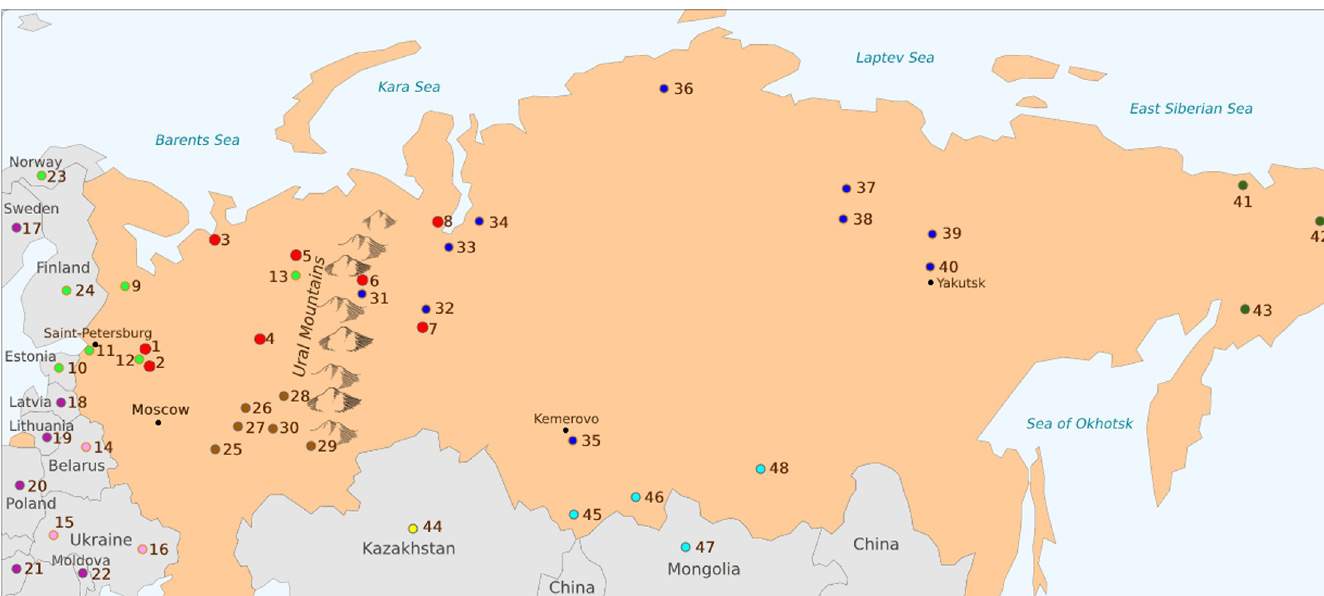
Fig 1. Geographical locations of the populations and samples studied. The numbers denote the following population samples: 1, Veps; 2, Russians from Ustyuzhna, Vologda region; 3, Russians from Mezen, Archangelsk region; 4, Priluzski Komi from Ob’yachevo District, Komi Republic; 5, Izhemski Komi from Izhma district, Komi Republic; 6, Mansi from Khanty-Mansi Autonomous Okrug; 7, Khanty from Khanty-Mansi Autonomous Okrug; 8, Nenets from Yamalo-Nenets Autonomous Okrug; 9, Karelians; 10, Estonians; 11, Ingrians; 12, Vepsas; 13, Komis; 14, Belarusians; 15, Ukrainians West; 16, Ukrainians East; 17, Swedes; 18, Latvians; 19, Lithuanians; 20, Poles; 21, Hungarians; 22, Moldavians; 23, Saami; 24, Finnish; 25, Mordvins; 26, Maris; 27, Chuvashes; 28, Udmurds; 29, Bashkirs; 30, Tatars; 31, Mansis; 32, Khantys; 33, Selkups; 34, Nenets; 35, Shor; 36, Nganasans; 37, Evenks; 38, Evens; 39, Sakha; 40, Kets; 41, Eskimo; 42, Chukchis; 43, Koryaks; 44, Kazakhs; 45, Altaians; 46, Tuvinians; 47, Mongolians; 48, Buryats. The numbers from 1 to 8 represent the samples genotyped by authors with microarrays and the rest were obtained from the Estonian Biocentre Human Genome Diversity Panel (EGDP [5,29]). The colors represent the following populations and groups of samples: red–datasets obtained with microarrays, sky blue–Altaians, yellow–Asia, deep green–Chukchi, magenta–Europe, light green–samples from North East Europe populations (NEE group), blue– samples from North West Asia populations (NWA group), pink–Slavs, brown–Tatar. The complete list of samples taken from the EGDP is presented in S3 Table (i.e., samples of non-Eurasian geography). The map was generated using R package tmap (v2.3–1) [30].